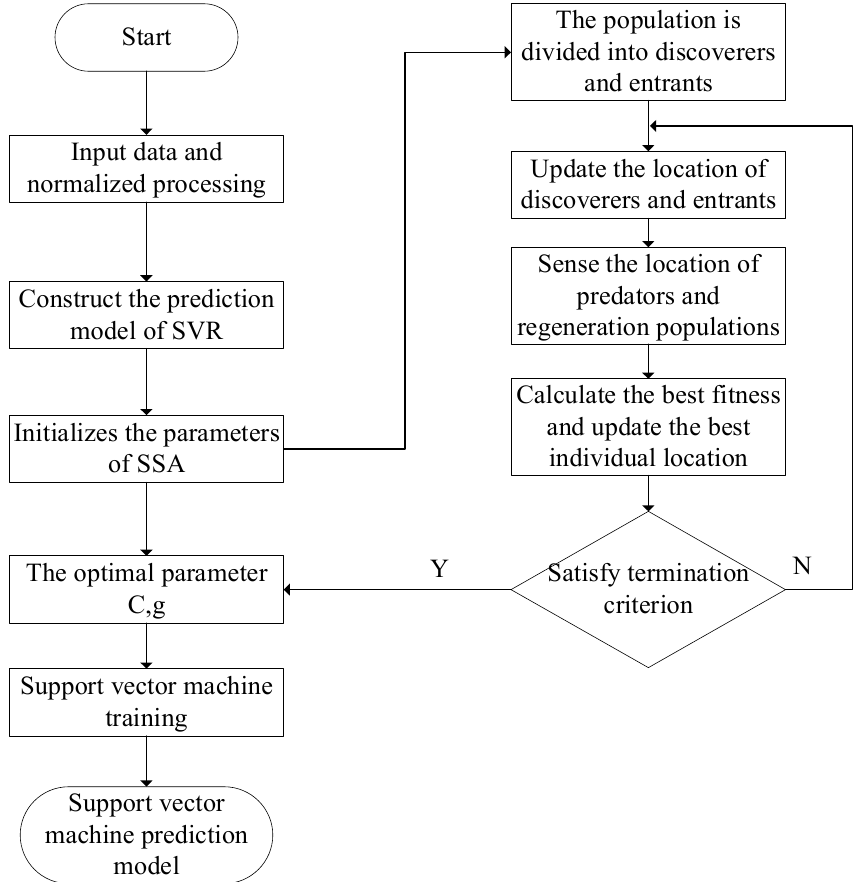
Figure 5. The specific flow chart of the SVR prediction model based on